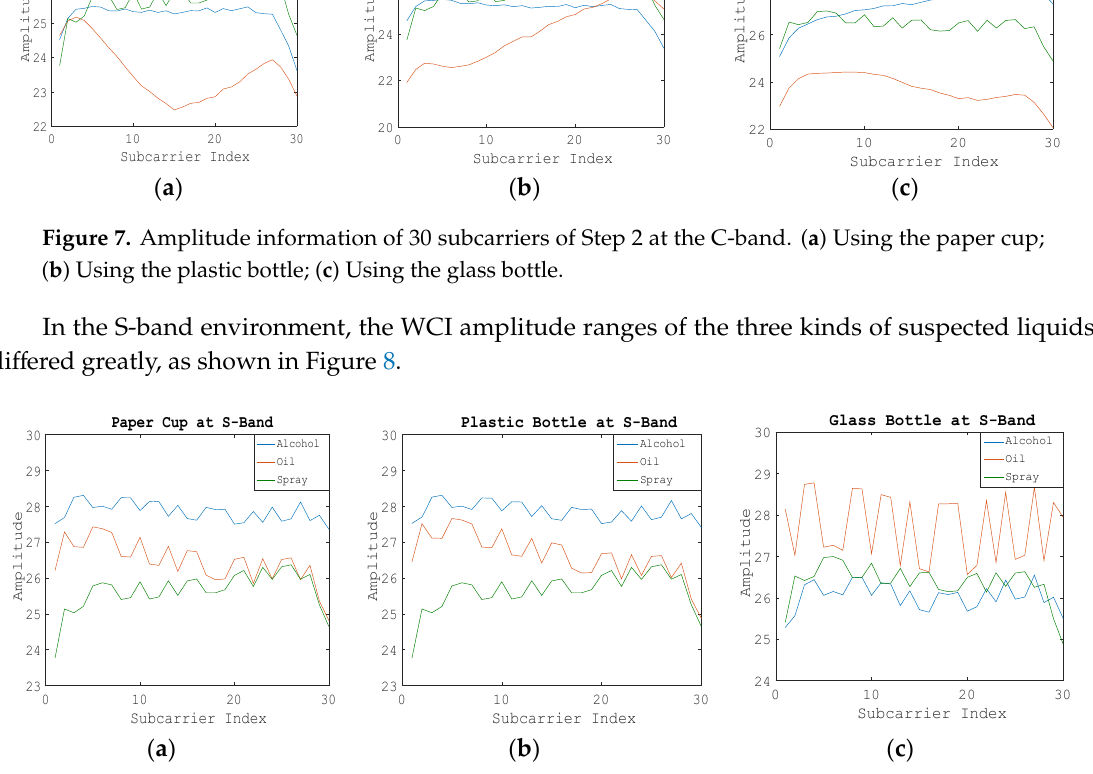
Figure 8. Amplitude information of 30 subcarriers of Step 2 at the S-band. ( a ) Using the paper cup; ( b ) Using the plastic bottle; ( c ) Using the glass bottle.